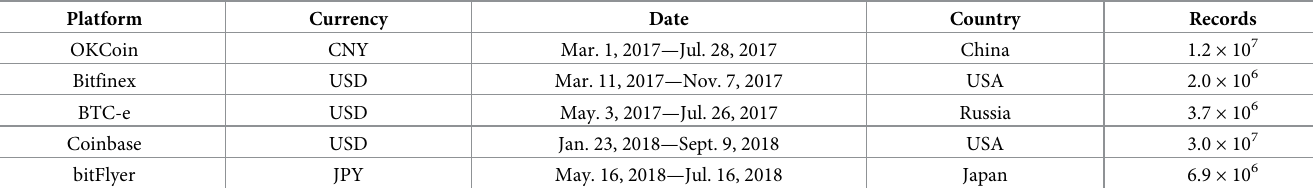
Table 1. The description of the data collected from OKCoin, Bitfinex, BTC-e, Coinbase and bitFlyer. Platform